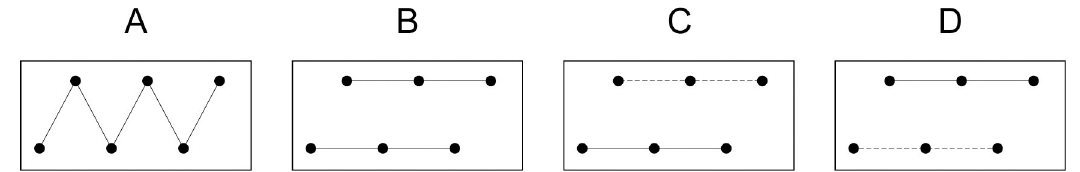
Fig 2. Perceptual alternatives in the multistable condition. Original depiction taken from the paper instruction; dots: single sounds; lines: perceptual organization (solid: foreground; dashed: background); A ) Integrated percept (“int”); B ) Segregated percept, both streams in the foreground (“seg_both”); C ) Segregated percept, low stream in the foreground (“seg_low”); D ) Segregated percept, high stream in the foreground